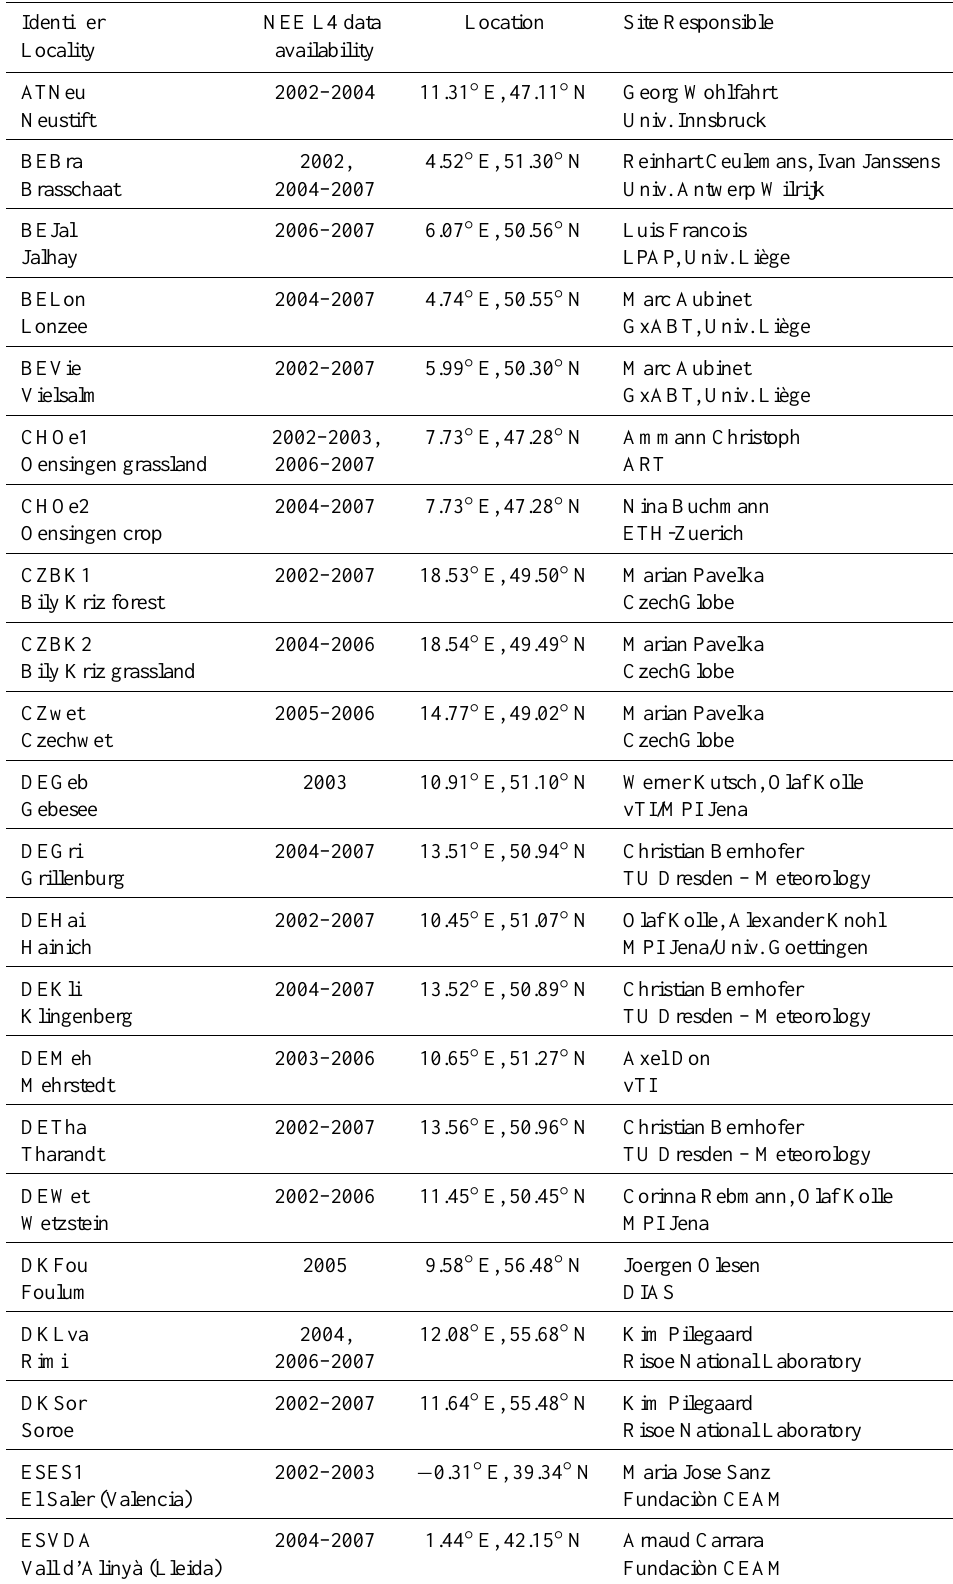
Table 2. CE eddy covariance sites providing the NEE L4 data used in this